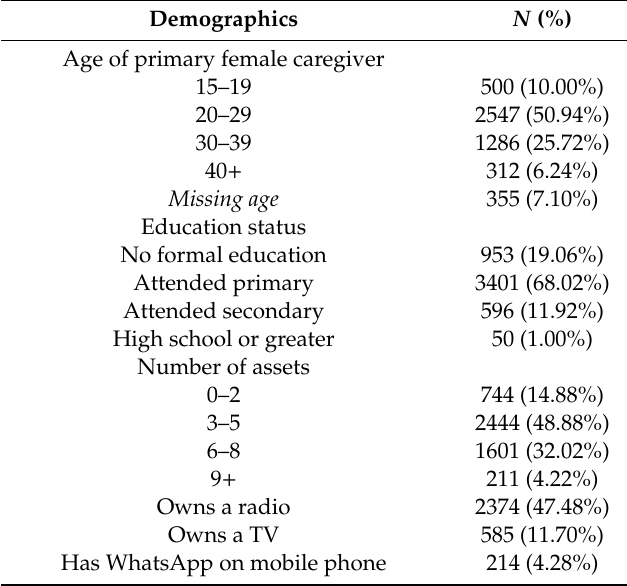
Table 1. Participant demographics, n = 5000.